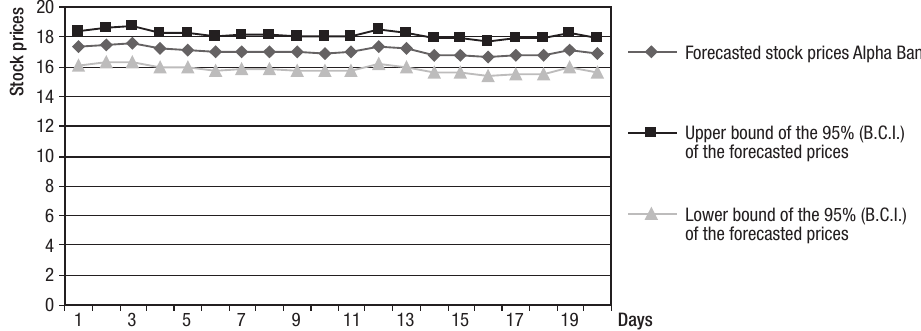
Fig. 4. Observed – Forecasted prices of Alpha Bank stock prices, the upper and lower bound of the 95% (C.I.) of the forecasted prices for the 20 days since 1/12/2005 and the period